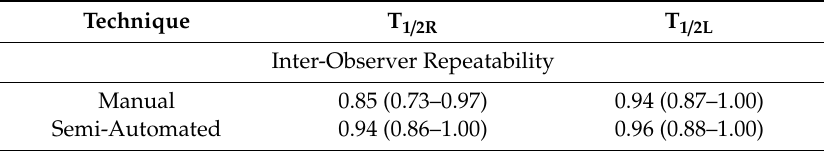
Table 8. Inter-observer repeatability for T 1 / 2 assessed with the Fleiss’ kappa statistic. Continuous T 1 / 2 values were transformed to ordinal scale (1, 0–10 min; 2, 10–20 min; 3, ≥ 20 min) and weighted kappa (95% confidence interval) was